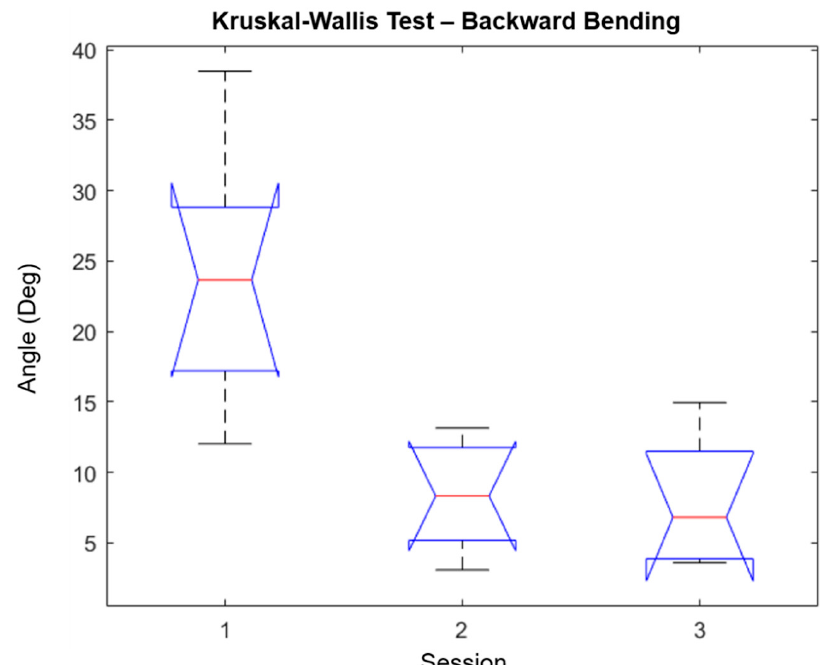
Figure 8. Kruskal–Wallis test for backward bending. The notch in sessions 2 and 3 does not overlap with the notch in session 1, which means that they have different medians (Q2/50th Percentile) at the 5% significance level. Q1 is decreasing in sessions 2 and 3 in comparison to session 1. Q3 has a decreasing trend over the three sessions.